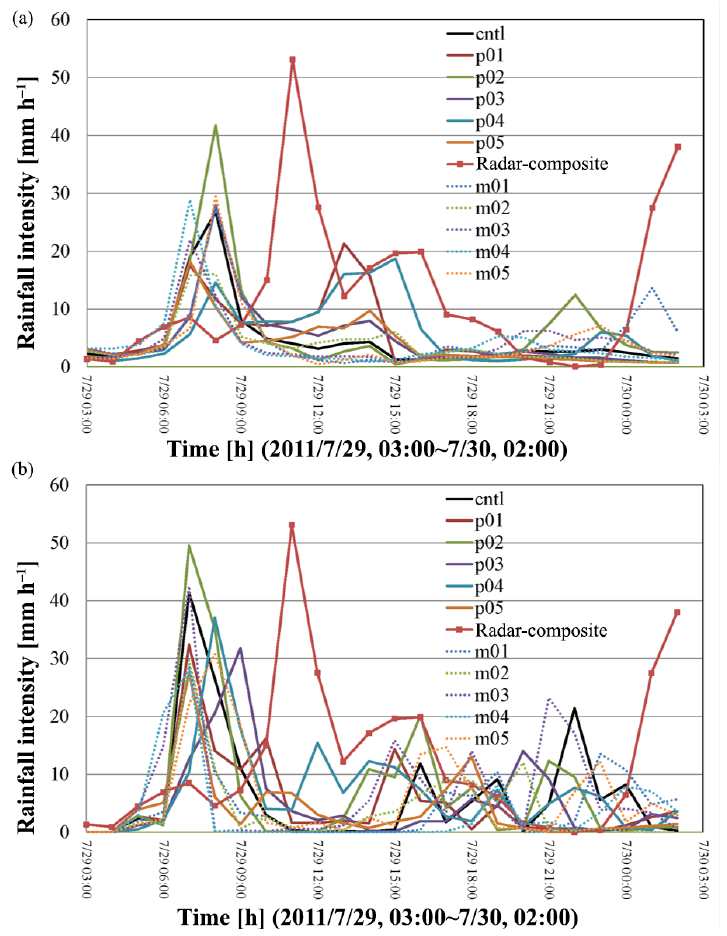
Figure 12. Catchment-averaged rainfalls with JMA-NHM 10km resolution ensemble simulation (upper) and with JMA-NHM 2km resolu- tion ensemble simulation